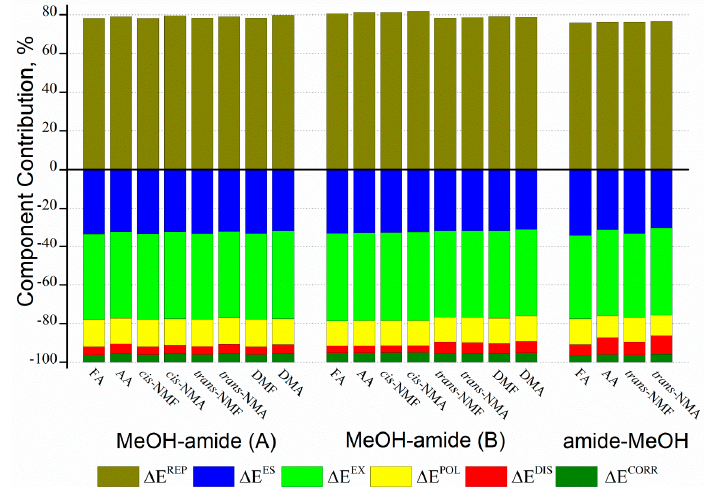
Figure 6. The six components’ contribution (%) to the total interaction energy in generalized Kohn-Sham energy decomposition analysis (GKS-EDA) at the B3LYP-D3/aug-cc-pVTZ level; Positive values are the repulsive component (repulsion energy (E REP )), and the negative values are the attractive components (electrostatic energy (E ES ), exchange energy (E EX ), polarization energy (E POL ), correlation energy (E CORR ) and Grimme’s dispersion energy (E DISP )); FA: formamide; NMF: N -methylformamide; DMF: N , N -dimethylformamide; AA: acetamide; NMA: N -methylacetamide; DMA: N , N -dimethylacetamide.